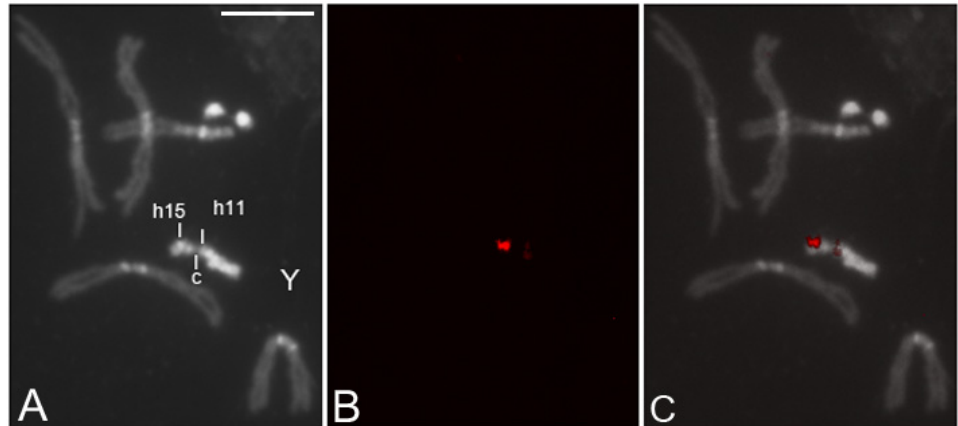
Figure 7. ( A – C ) Localization by fluorescence in situ hybridization of the F6.3 clone on the D. simulans mitotic chromosomes. Two signals map on the Y chromosome. The strong hybridization signal is located on the short arm of the Y chromosome, in the h15 band; a second faint signal maps in the h11 region, beside the centromere. Scale bar indicates 5 µm.